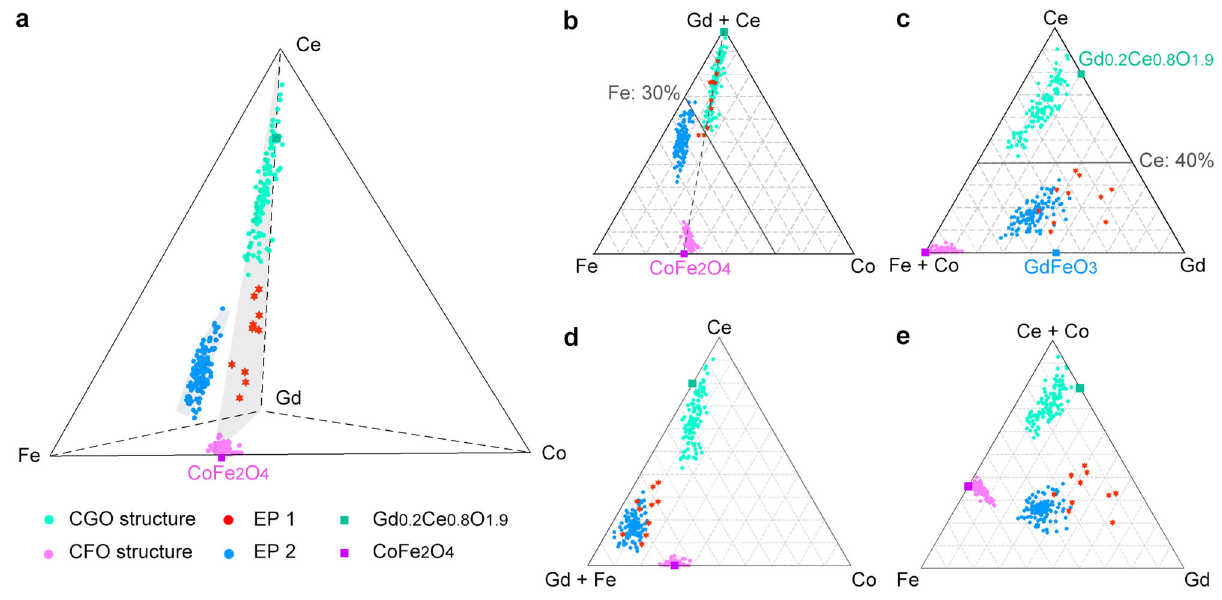
Fig. 4 Composition distribution for four material phases (CGO, CFO, EP1, and EP2). a On the quaternary phase diagram. Note that the composition ranges CGO, CFO and EP1 are con fi ned in a single composition plane de fi ned by three points: Ce apex, Gd apex, and the bulk CFO composition value. The composition range of EP2 is categorically displaced from others, restricted to another composition plane that is nearly but not exactly parallel to the plane containing the three phases. b – e ternary phase diagrams: Fe-Co-Gd + Ce ( b ), Gd-Ce-(Fe + Co) ( c ), Ce-Co-(Gd + Fe) ( d ), and Gd-Fe-(Ce + Co) ( e ). Only four of all six phase diagrams are shown. See SI for all phase diagrams. As expected, the CFO grains exhibit a small concentration range close to CoFe 2 O 4 (represented as a pink square in b ). The CFO grains display coordination of the Gd and Co concentrations, producing a short elongated compositional streak. The CGO grains exhibit a highly elongated composition spread, aligned with the dotted line in b , representing the Fe to Co concentration ratio of 2 ([Fe]/[Co] = 2). The EP1 grains share an identical Fe-Co compositional relationship as the CGO grains while displaying drastically different Gd and Ce composition ranges (see c – e ). The EP2 grains exhibit their Fe-Co composition spread, abruptly shifted from the CGO and EP1 grains at ~30% Fe (see solid line in b ) with very narrow Fe and Gd compositional ranges of co-existence (see b and e ).